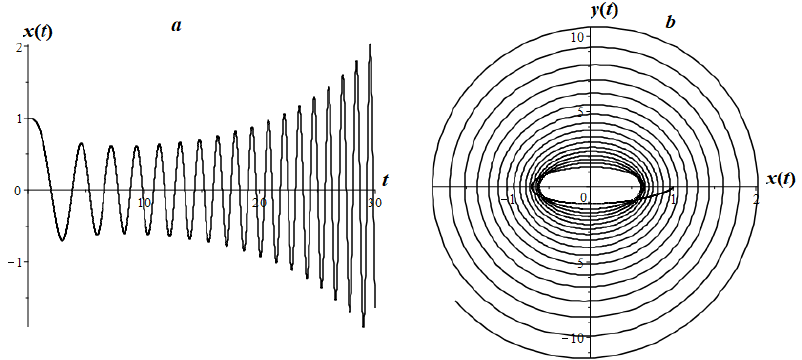
Figure 21. The classic Airy oscillator: ( a ) oscillogram; ( b ) phase trajectory.